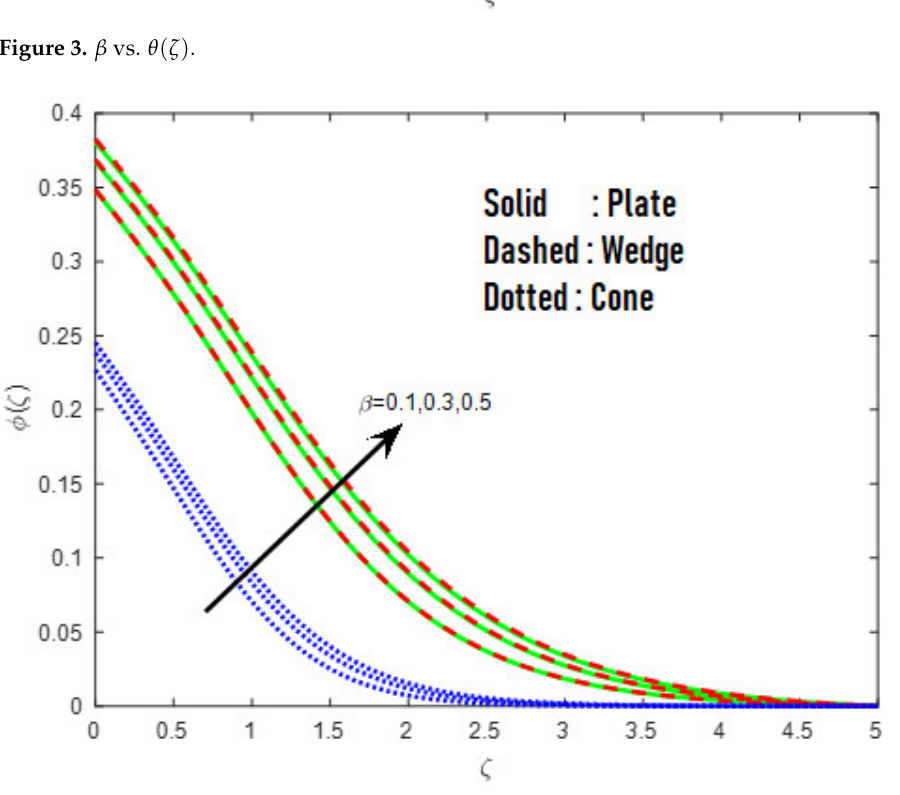
Figure 4.  vs. concentration field. Figure 4. β vs. concentration